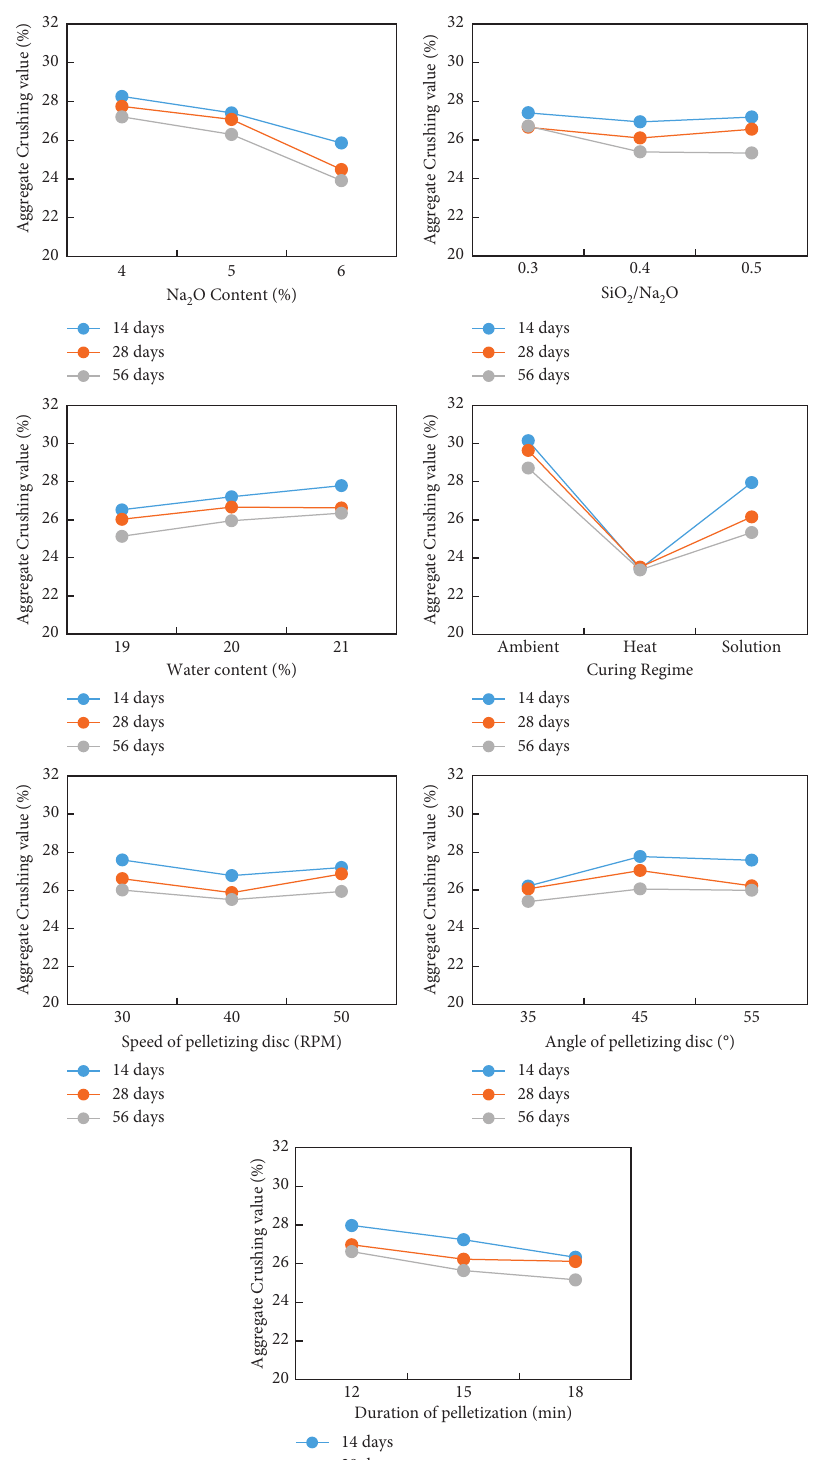
Figure 5: Response index relationship for aggregate crushing value with combined